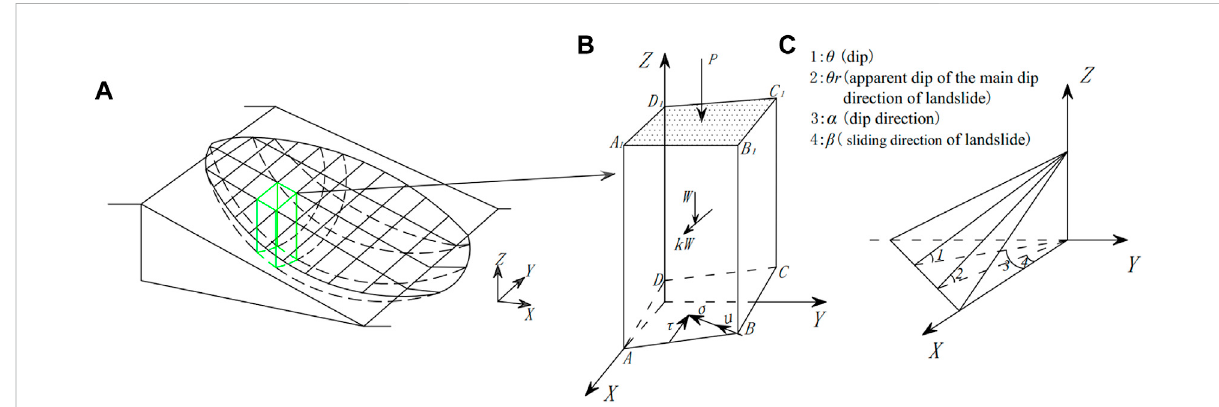
FIGURE 1 Computationalmodelingandthree-dimensionalspatialrelationship. (A) 3Dmodelofslidebody, (B) typicalcolumnforceanalysis, (C) 3Dspatial relationship.